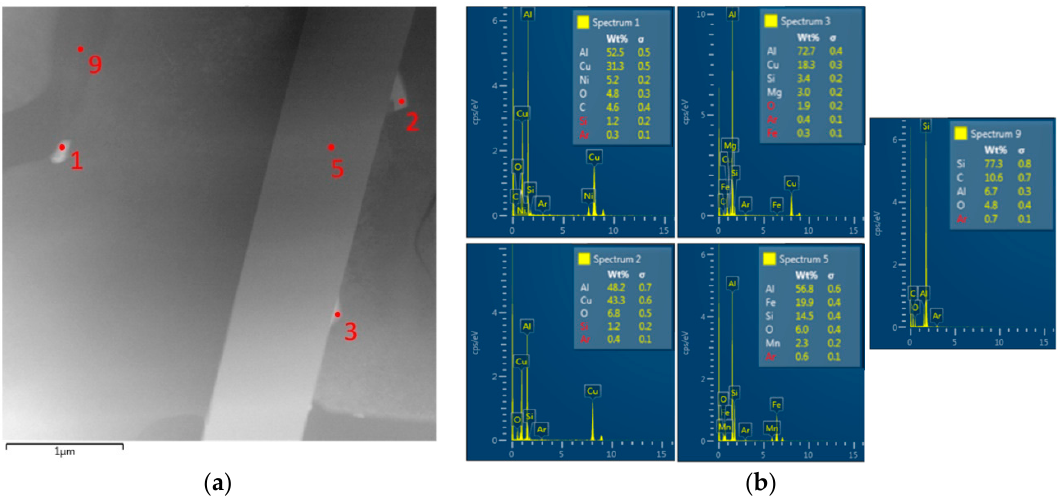
Figure 10. Point EDX analysis of 20–80 alloy substructure after natural aging; ( a ) Places of point EDX analysis, ( b ) Results of chemical composition of structural components.